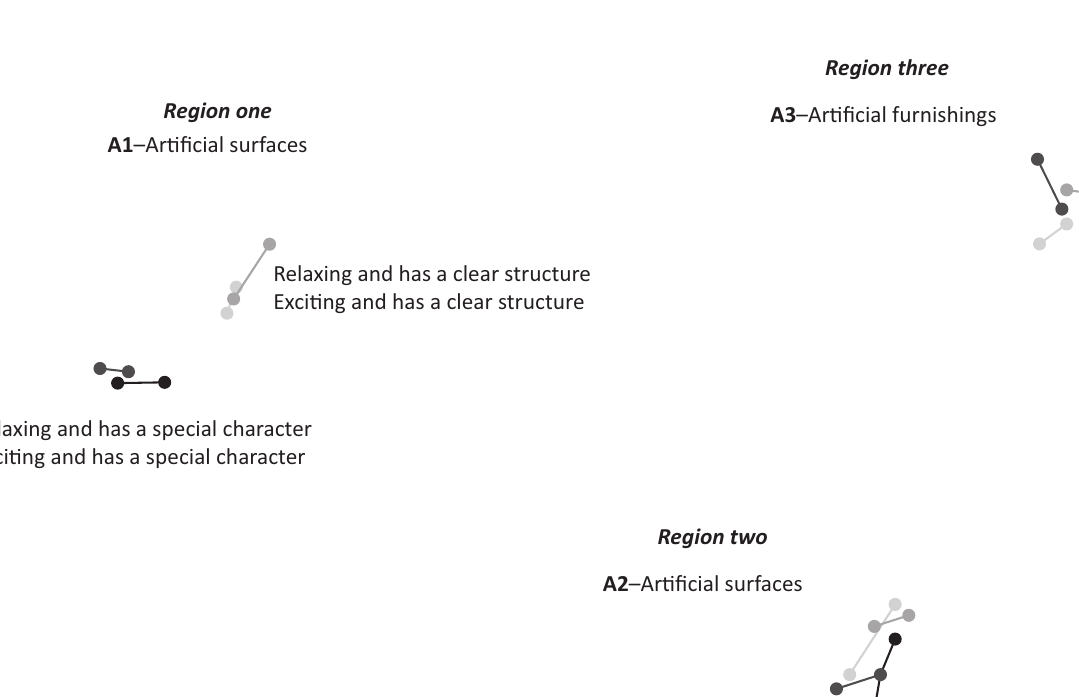
Figure 4. Two-dimensional spatial representation of 24 artificial items classified according to mental image (stress = 0.05; N =